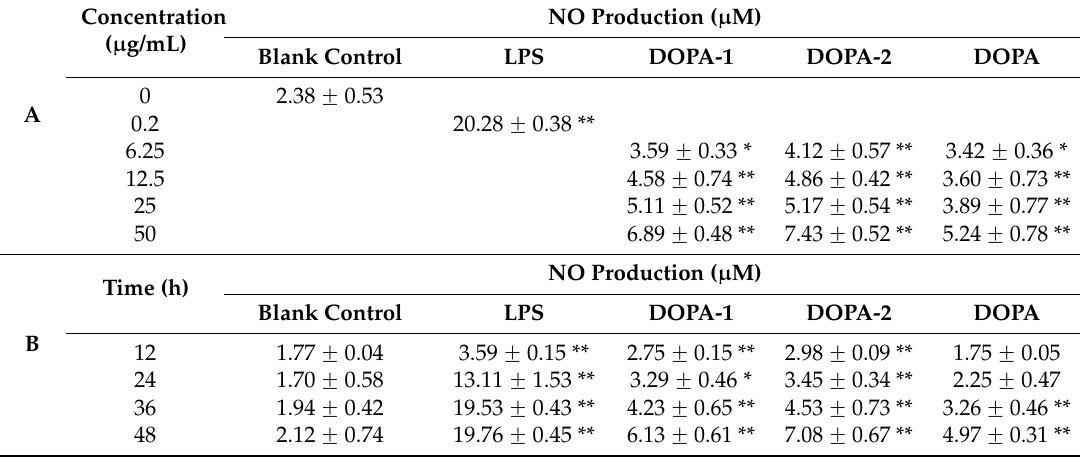
Table 3. Effects of D. officinale polysaccharides on the production of NO in RAW 264.7 cells.